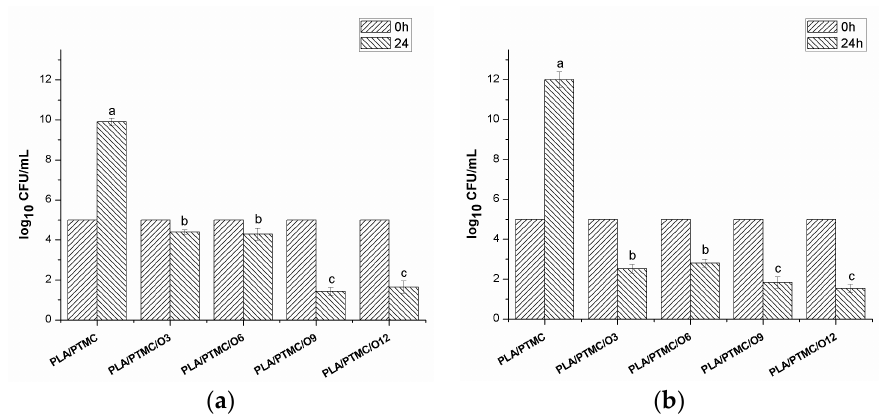
Figure 6. Antimicrobial activity of poly(lactic acid)/poly (trimenthylene carbonate)/oregano essential oil composite films ( a ) Listeria monocytogenes ; ( b ) Escherichia coli . Values followed by different letters (a–c) were significantly different ( p < 0.05).